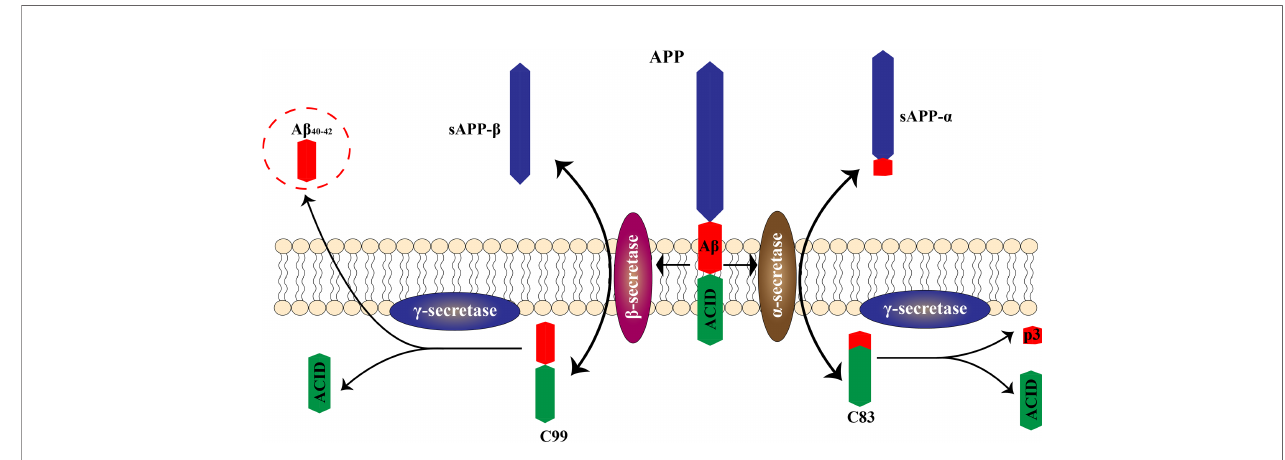
FIGURE 1 | Pathological and physiological APP metabolism. APP is cleaved by two enzymes, a secretase and b secretase, resulting in different outcomes. a secretase excises the amyloid region, preventing A b production. The co-produced C83 protein and sAPP a enter the cytoplasm without causing neurotoxicity. The b -secretase cleavage site bypasses the amyloid region, producing sAPP b and C99. Further processing of C99 leads to production of intracellular binding domain of amyloid precursor protein (AICD) fragments and A b . A b molecules bind each other to form oligomers, eventually forming fi bers that are